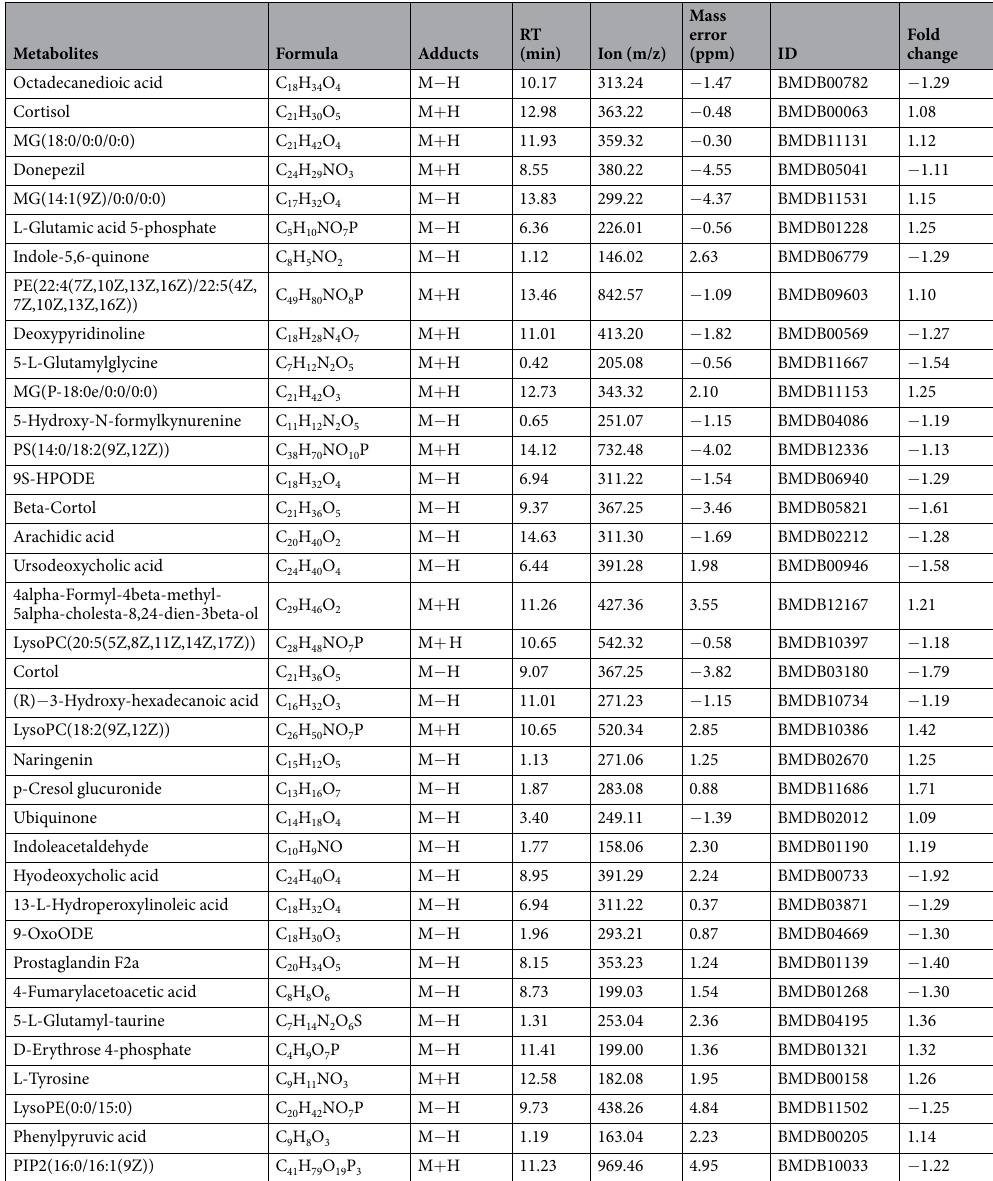
Table 1. Identification of ruminal fluid metabolites for feed efficiency. UPLC-qTOF metabolites identified ( P < 0.1), RT, retention time; ID, identification matched from bovine metabolome database matched, fold changes comparing high-ADG vs. low-ADG